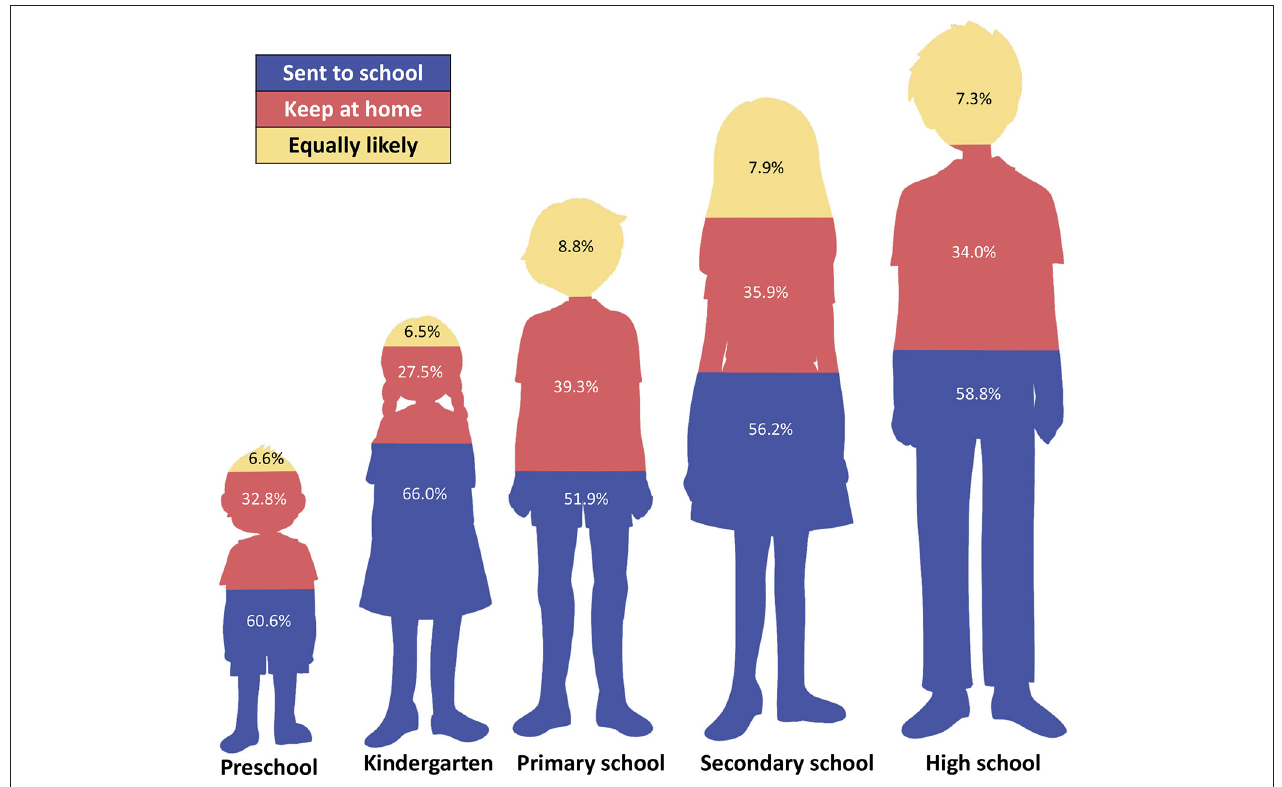
FIGURE 1 | Parents’ attitude toward school reopening according to children’s education level.